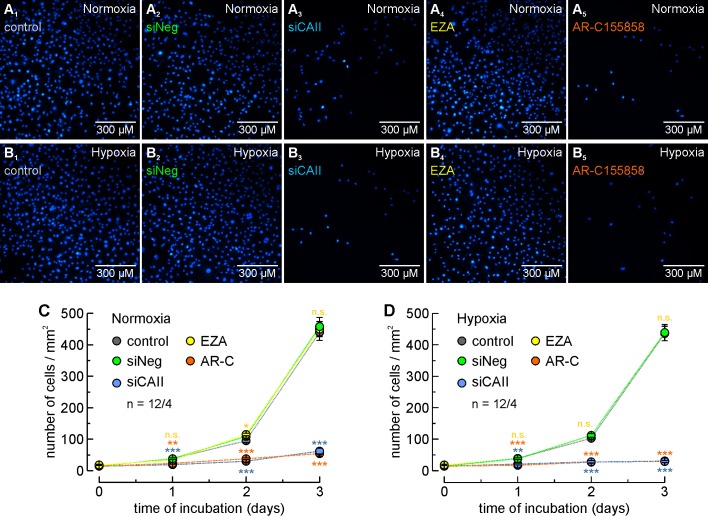
CAII supports proliferation of MCF-7 breast cancer cells.(A, B) Staining of nuclei with Hoechst 33342 (blue) in MCF-7 cells after 3 days in culture under normoxic (A) or hypoxic (B) conditions. Cells were untreated (control; A1, B1), mock-transfected with non-targeting negative control siRNA (siNeg; A2, B2), transfected with siRNA against CAII (siCAII; A3, B3), incubated with 30 µM of the CA inhibitor EZA (A4, B4), or incubated with 300 nM of the MCT1 inhibitor AR-C155858 (A5, B5). (C, D) Total number of nuclei/mm2 in normoxic (C) and hypoxic (D) MCF-7 cell cultures, kept for 0–3 days under the conditions described for (A) and (B). For every data point, four dishes of cells were used and three pictures were taken from each dish at random locations, yielding 12 pictures/data points (n = 12/4). The blue asterisks indicate significance in differences between siCAII and siNeg, the orange asterisks between control and AR-C155858, and the yellow significance indicators between control and EZA. *p≤0.05, **p≤0.01, ***p≤0.001, n.s. no significance; Student’s t-test.10.7554/eLife.35176.010Figure 3—source data 1.Original dataset for Figure 3.